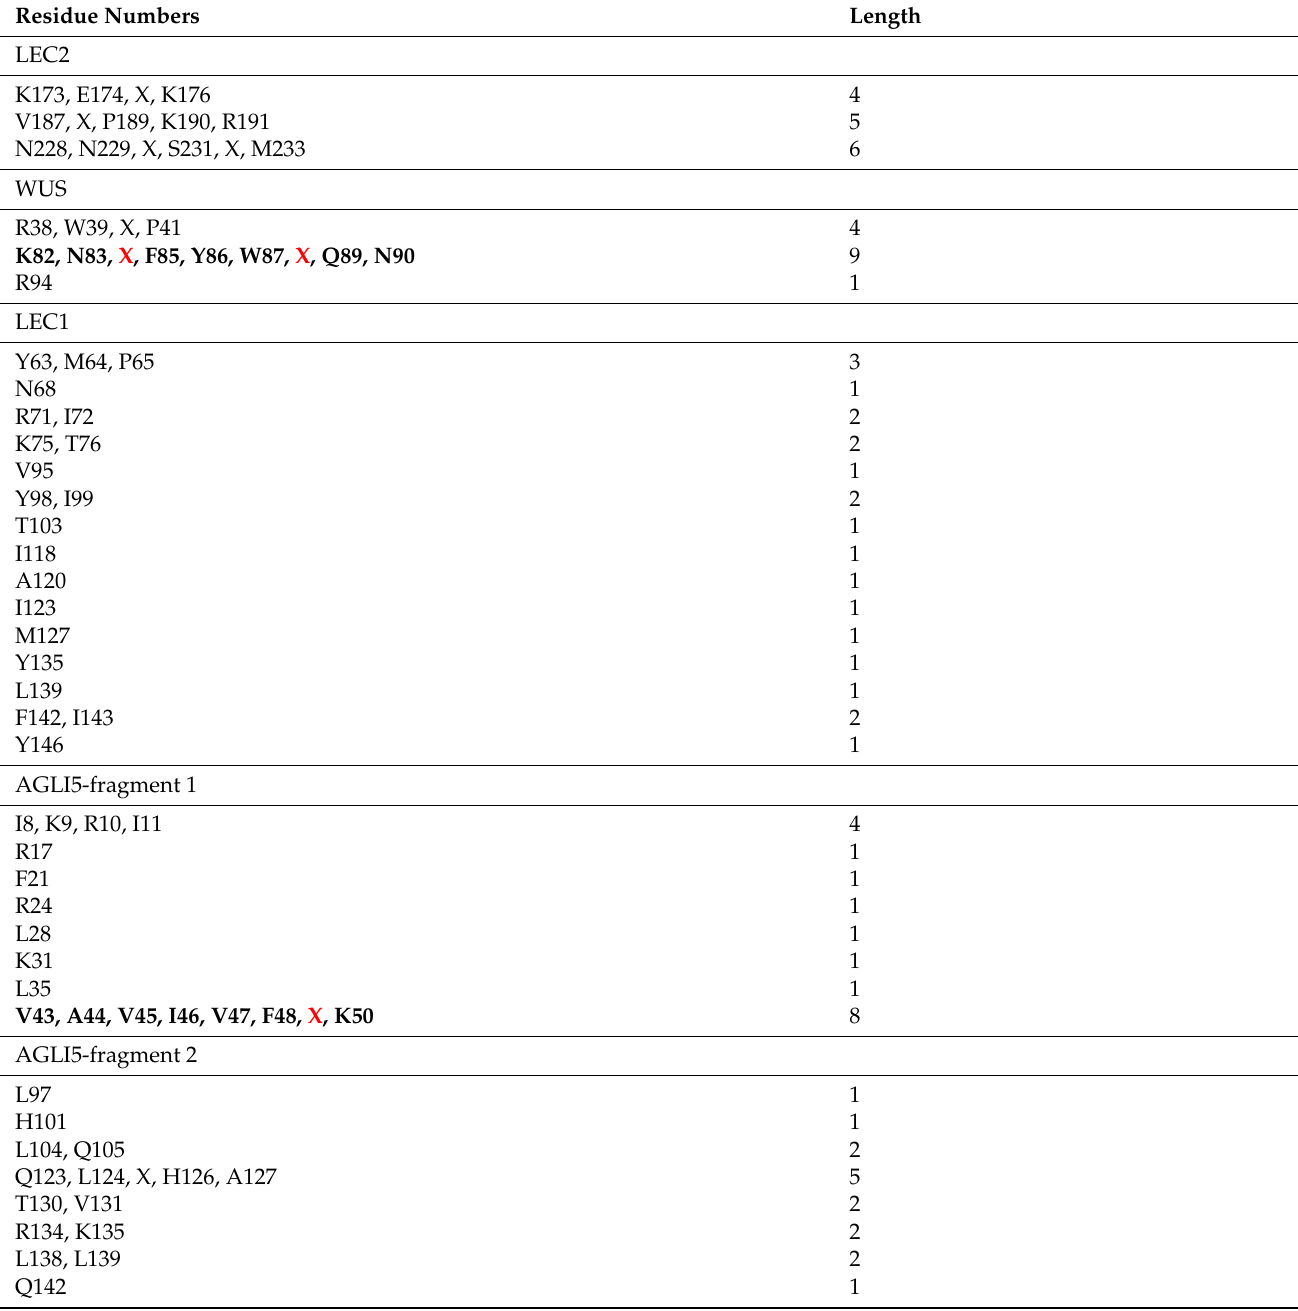
Table 5. Continuous stretches of amino acid residues of the interacting partner proteins at the interface of the BBM protein for fragment 2. Selected stretches are shown in